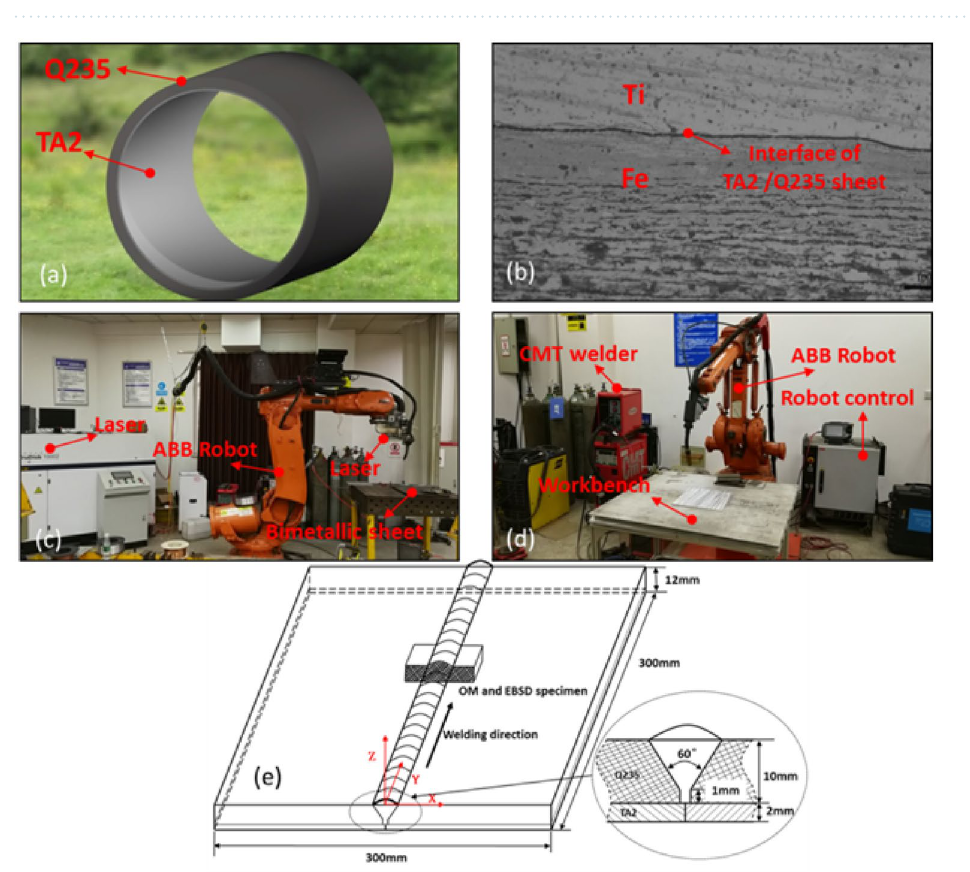
Figure 12. Schematic design for the investigation of titanium alloys with carbon steel compound plates. (a,b) From west to east natural gas transmission and the titanium alloys with carbon steel compound plates. (c) LAW equipment. (d) CMT equipment. (e) Schematic of LAHW process and location of sample